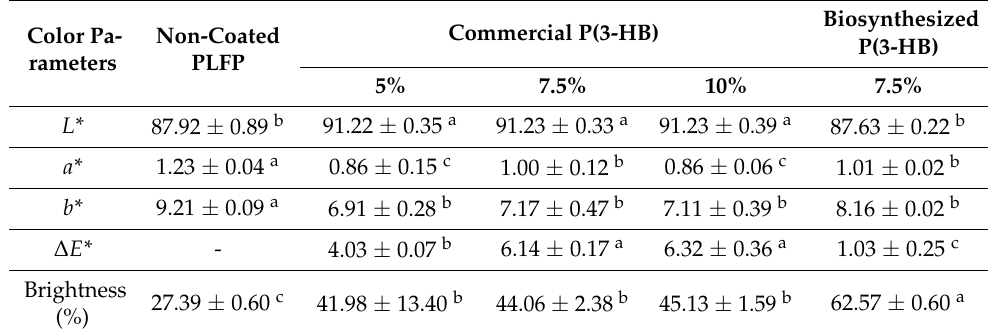
Table 3. Colorimetric parameters of the non-coated PLFP, the commercial P(3-HB) coated PLFPs at 5, 7.5 and 10% ( w/v ) and the biosynthesized P(3-HB) coated PLFP at 7.5% ( w/v ).